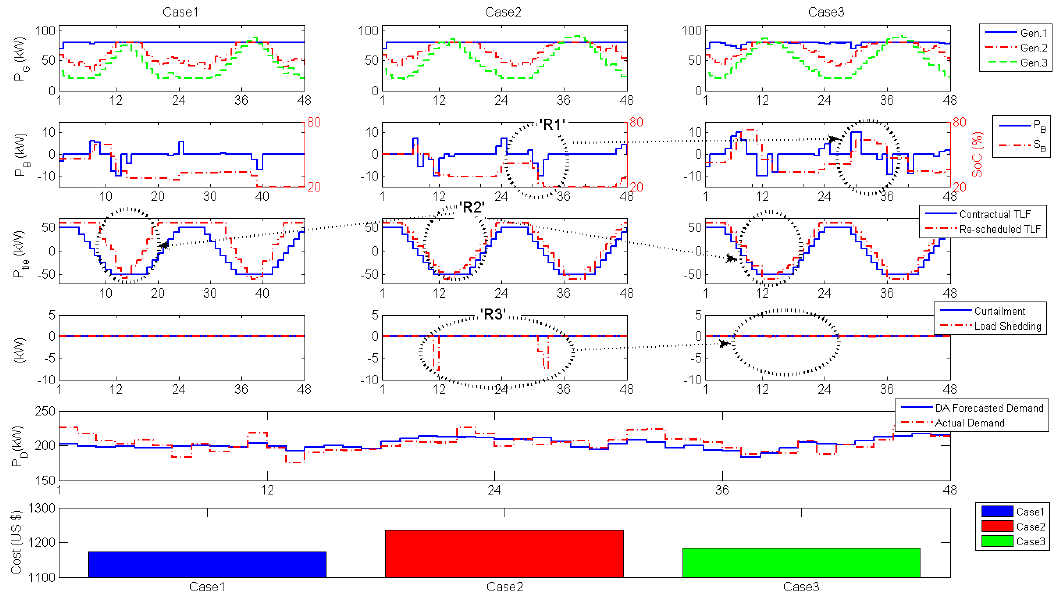
Figure 6. Optimal trajectories and operational costs of DERs/TLF under different MG operational strategies.